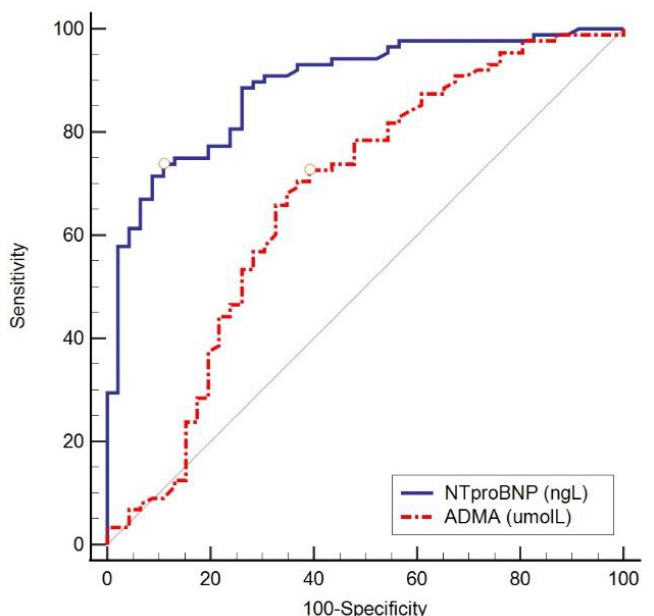
Figure 2. ROC curve comparing NT-proBNP and ADMA in different groups of subjects with LVDD grade 1 and LVDD grades 2 and 3. NT-proBNP was a better diagnostic indicator of the existence of LVDD grades 2 and 3 (AUC 0.889, 95% CI 0.833 – 0.945, sensitivity 73.9%, specificity 89.1%, cut-off values > 220 ng/L, Youden index 0.63, p < 0.001) compared to ADMA (AUC 0.673, 95% CI 0.570 – 0.777, sensitivity 72.7%, specificity 60.9%, cut- off values ≤ 0.433 µmol/L, Youden index 0.34, p = 0.001).